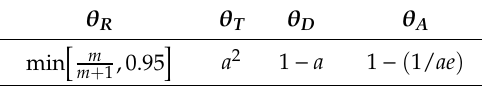
Table 2. Kariwala tuning rules